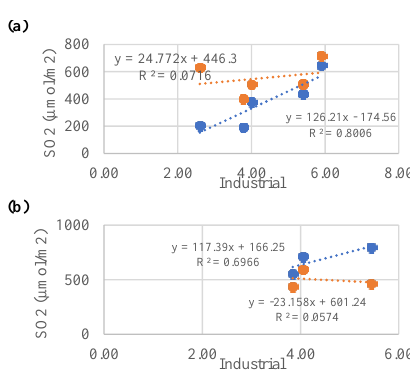
Figure 13. Influence of industrial landuse on SO 2